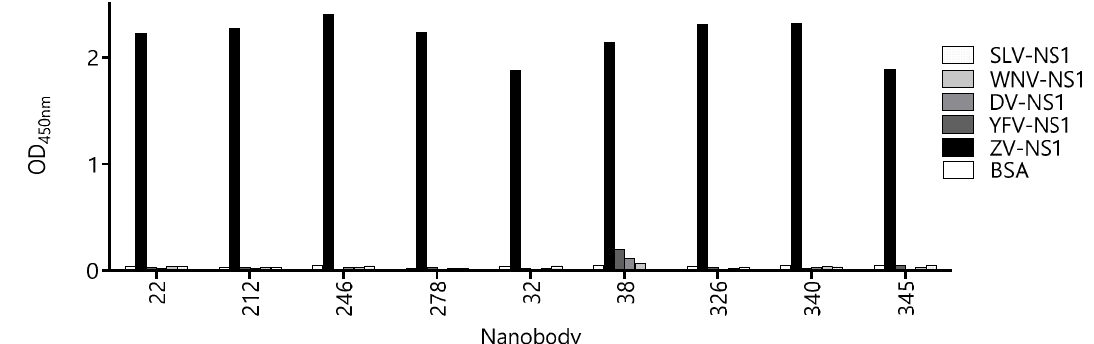
Figure 4. Evaluation of the cross-reactivity of the capture nanobody candidates against different flavivirus NS1 proteins. A fixed concentration of antibody was loaded into wells coated with 100 ng of NS1 from Zika virus (ZV), Yellow Fever virus (YFV), Dengue type 1 virus (DV), West Nile virus (WNV), Saint Louis Encephalitis virus (SLV), and bovine serum albumin (BSA) as a negative control. Measurements were done by triplicates.